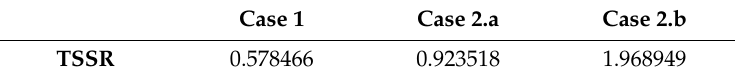
Table 3. Total sum of squared residuals